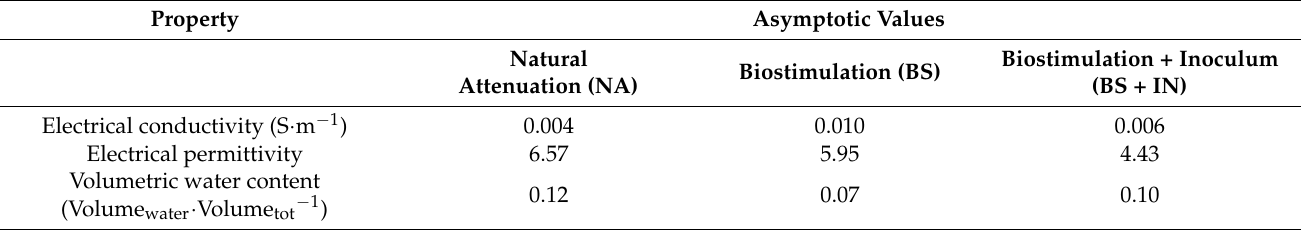
Table 2. Asymptotic values of the electromagnetic properties measured by TDR probes.